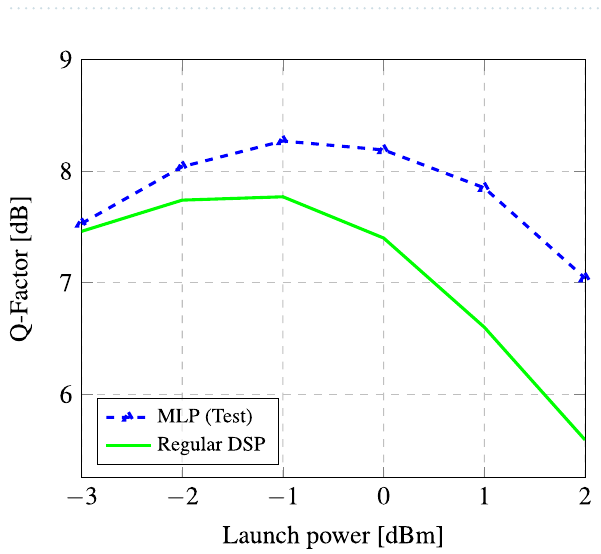
Figure 1. Structure of a communication channel that is equalized using a pruned and quantized neural network deployed on resource-restricted hardware (e.g. a Raspberry Pi 4 or a Nvidia Jetson Nano).